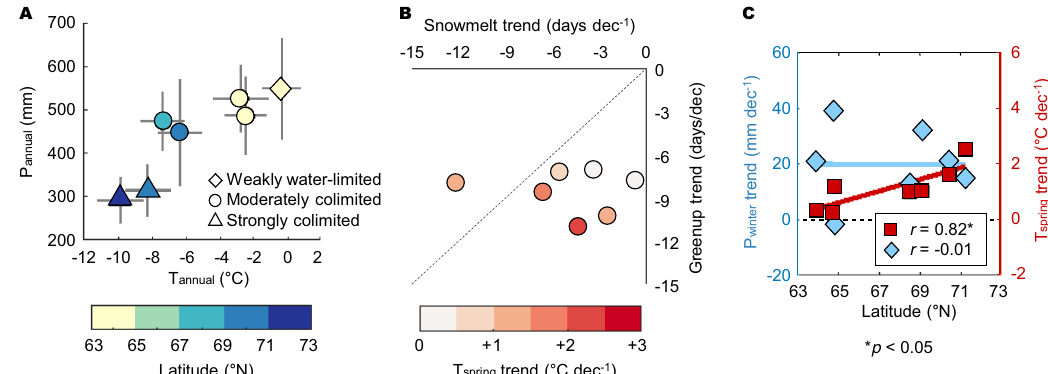
Fig. 2 Latitudinal gradients in climatic conditions and greenup and snowmelt timings. A Annual mean temperature (T annual ) and annual total precipitation (P annual ) at each site (2001 – 2018 means in symbols and one std. dev. in lines) with latitude (in color) and climatic limits (see Methods — Study sites). B Long-term trends of snowmelt and greenup timings at each site (in circles, Fig. S3) and the spring mean temperature trend (T spring , Apr. – Jun., in color). C Correlations of long-term trends of T spring and winter precipitation (P winter, Jan. – May) with